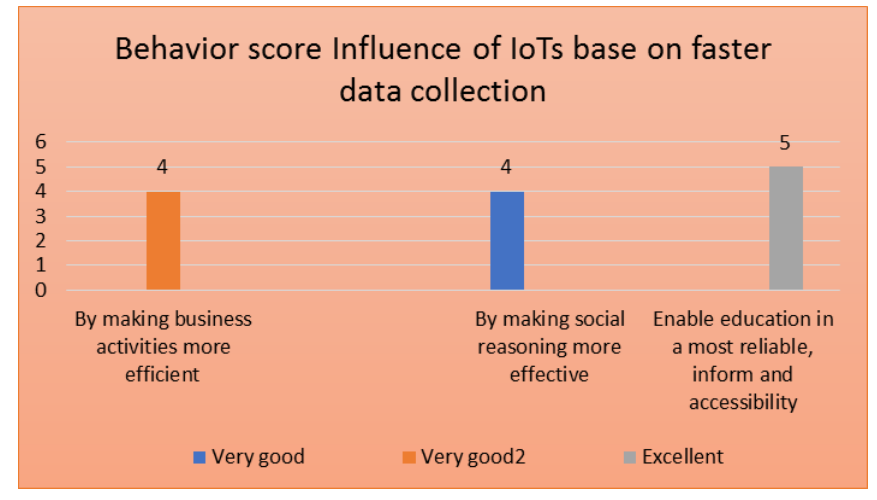
Figure 11. behavior score influence graph of fast data collection. Source: Owner